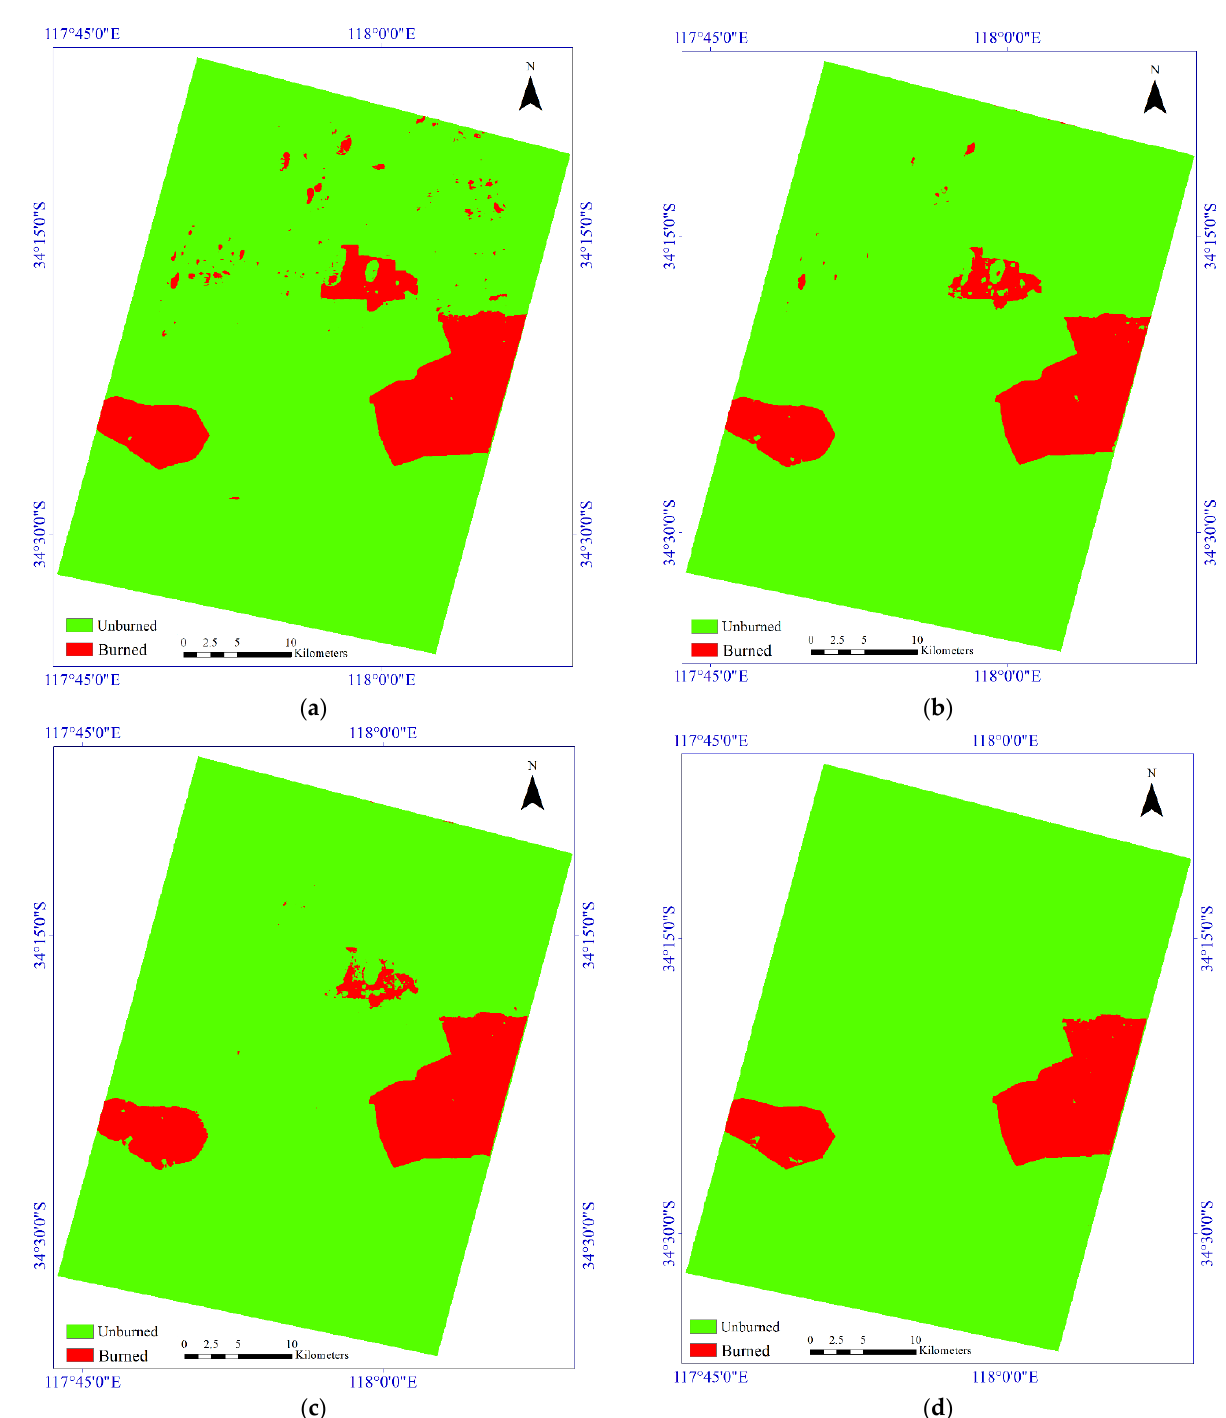
Figure 10. Visual comparisons of the results for the burned area mapping based on the pre-event Sentinel-2 and post-event PRISMA imagery for the second study area. ( a ) Deep Siamese network. ( b ) Using the CNN method proposed in [42]. ( c ) Using the DSMNN-Net. ( d ) Ground truth